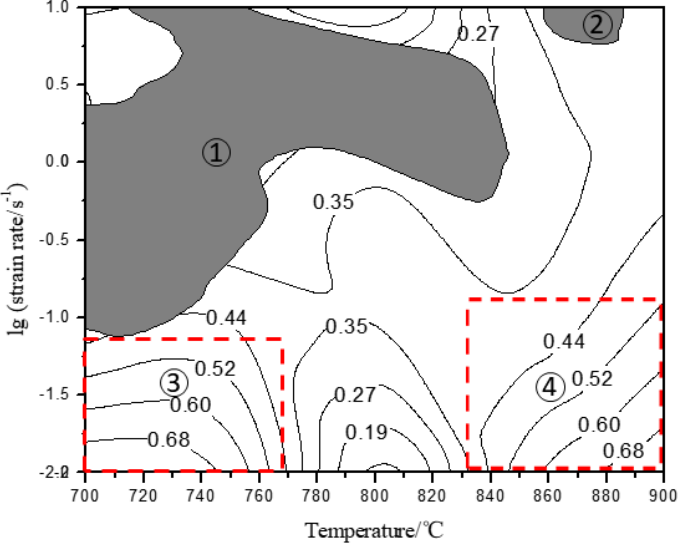
Figure 9. Processing map of TA1. ①,② are Plastic instability region; ③,④ are Suitable pro- cessing area.